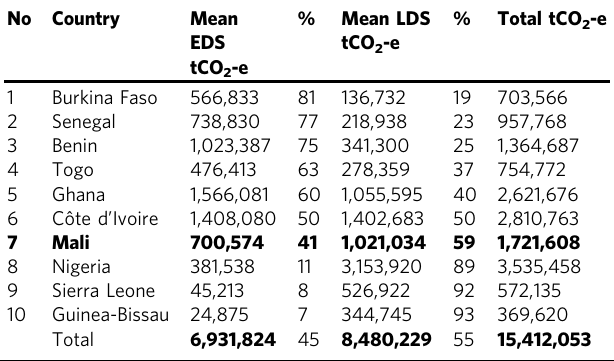
Table 1 Mean early dry season (EDS), late dry season (LDS) and total emissions for 10 West African savanna countries (>600 mm rainfall per year) generating greater than 50,000 tCO 2 -e yr − 1 LDS (data originates from Lipsett- Moore et al.